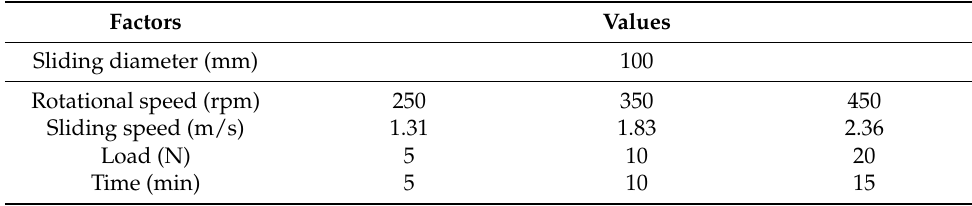
Table 2. Wear test experimental